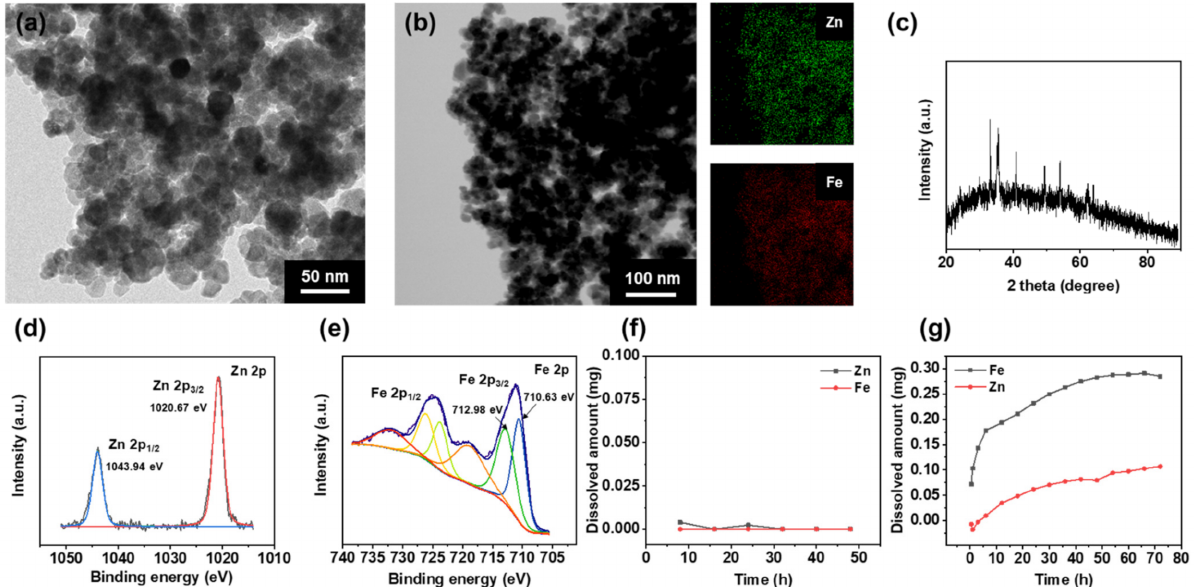
Figure 1. Characterization of the Zn-based iron oxide nanoparticles (ZIOs). ( a ) The representative transmission electron microscopy (TEM) image and ( b ) energy dispersive spectroscopy (EDS) elemental mapping image with ( c ) the X-ray diffraction (XRD) pattern of Zn-based IONs. High resolution XPS spectra of ( d ) Zn 2p and ( e ) Fe 2p. ( f ) Zn, Fe ion dissolution graph of the ZIOs in pH 7 controlled solution. ( g ) Cumulative release profiles of Zn, Fe ions from ZIOs under a pH 4.5